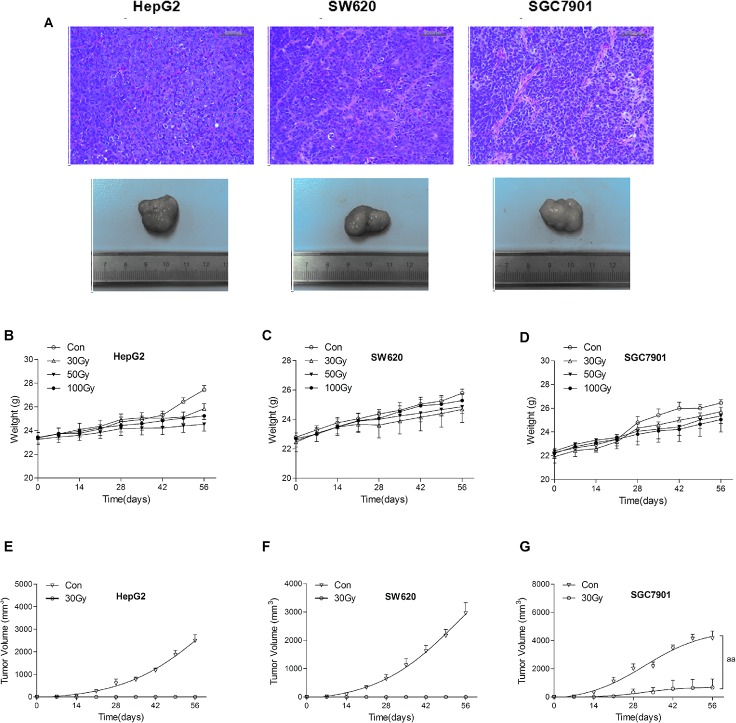

137Cs gamma-ray irradiation inhibits the growth of xenograft tumors in immunocompromised mice.After 137Cs gamma-ray irradiation (0, 30, 50 and 100 Gy), HepG2, SW620 and SGC7901 cells separated from human erythrocytes were subcutaneously xenotransplanted into male BALB/c nude mice. The histopathology of xenograft tumors growing up to 2 cm in diameter was detected by H&E staining. Representative subcutaneous xenograft tumor and histopathology of xenograft tumor developed by non-irradiated HepG2, SW620 and SGC7901 cells (scale bar: 50 μm) with H&E staining (A). The body weights of immunocompromised mice subcutaneously xenotransplanted with HepG2 (B), SW620 (C) and SGC7901 (D) cells. The volume of xenograft tumors developed by HepG2 (E), SW620 (F) and SGC7901 (G) cells subjected to 0 and 30 Gy irradiation in immunocompromised mice. Date are means ± SEM; n = 8 mice in each group. aa
P<0.01 vs. Con (the dose of irradiation was 0 Gy).